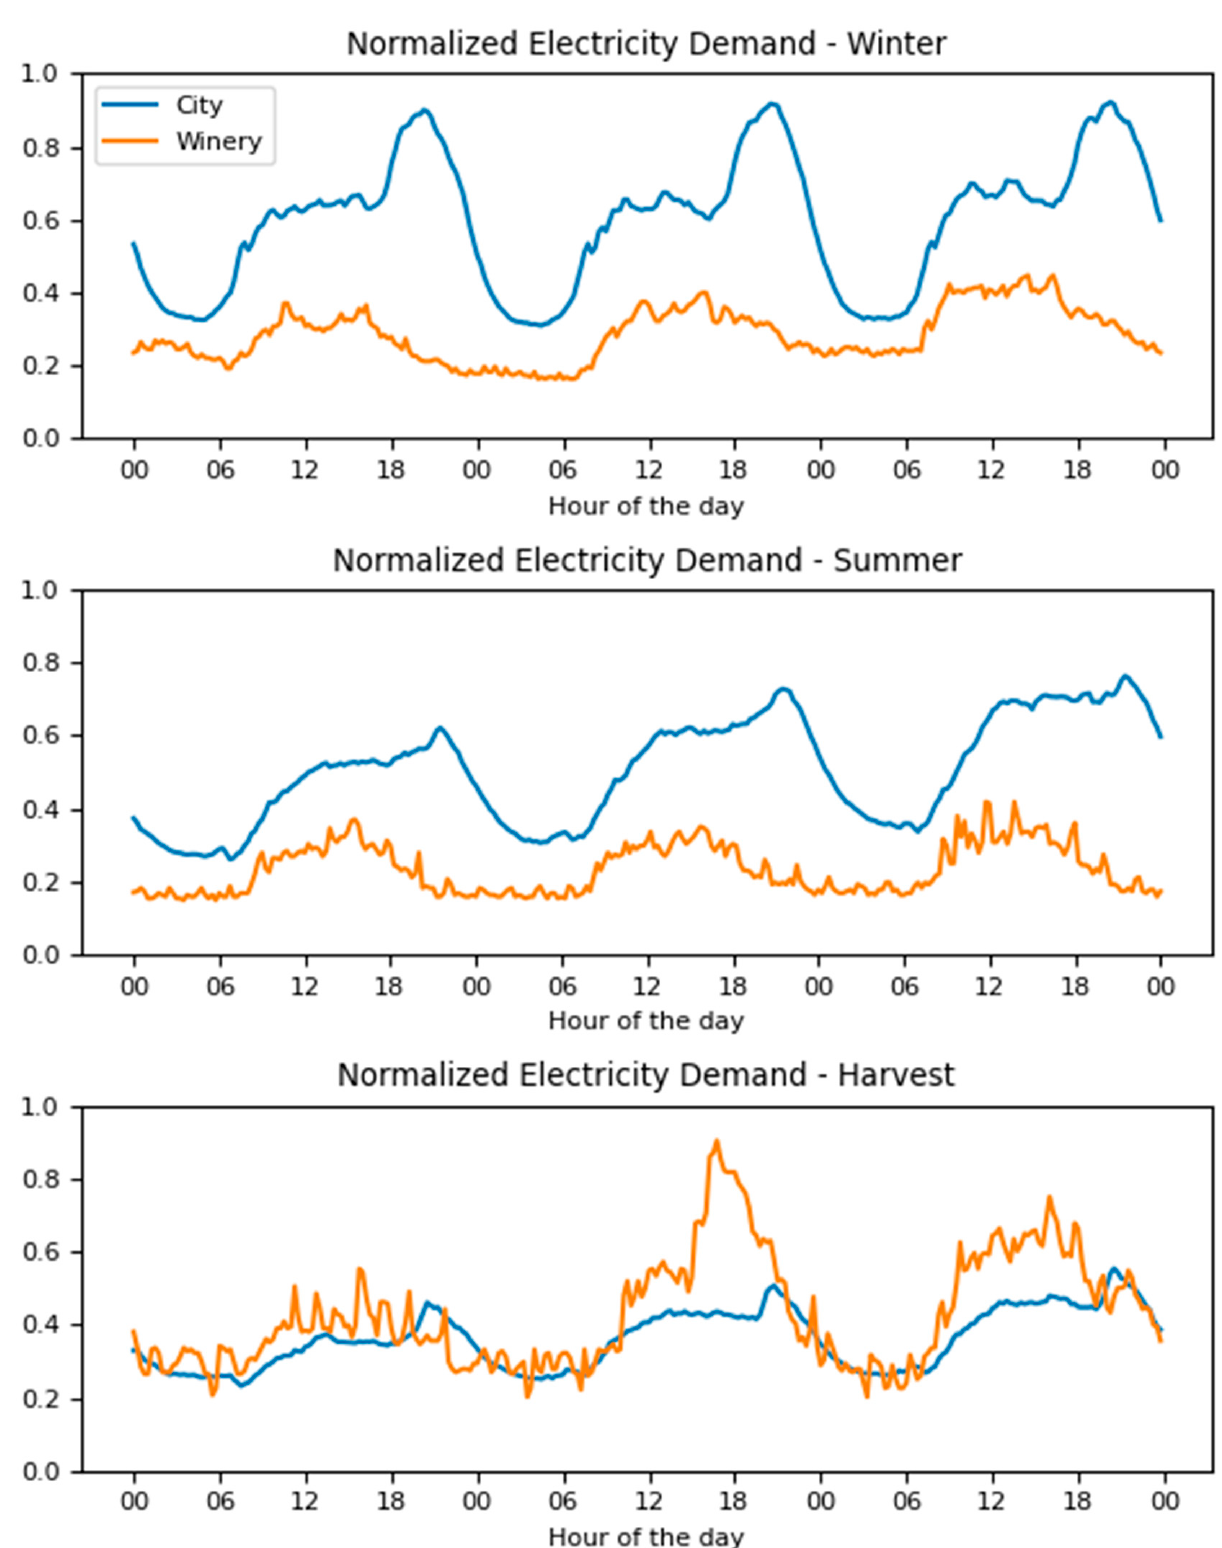
Figure 4. Normalized 15-min electricity demand profiles for the city of Reguengos de Monsaraz and a local winery with sets of three days for three different seasons of the year: wintertime (January 10th to 12th), summertime (August 1st and 3rd), and the winery harvesting period (September 9th to 11th).